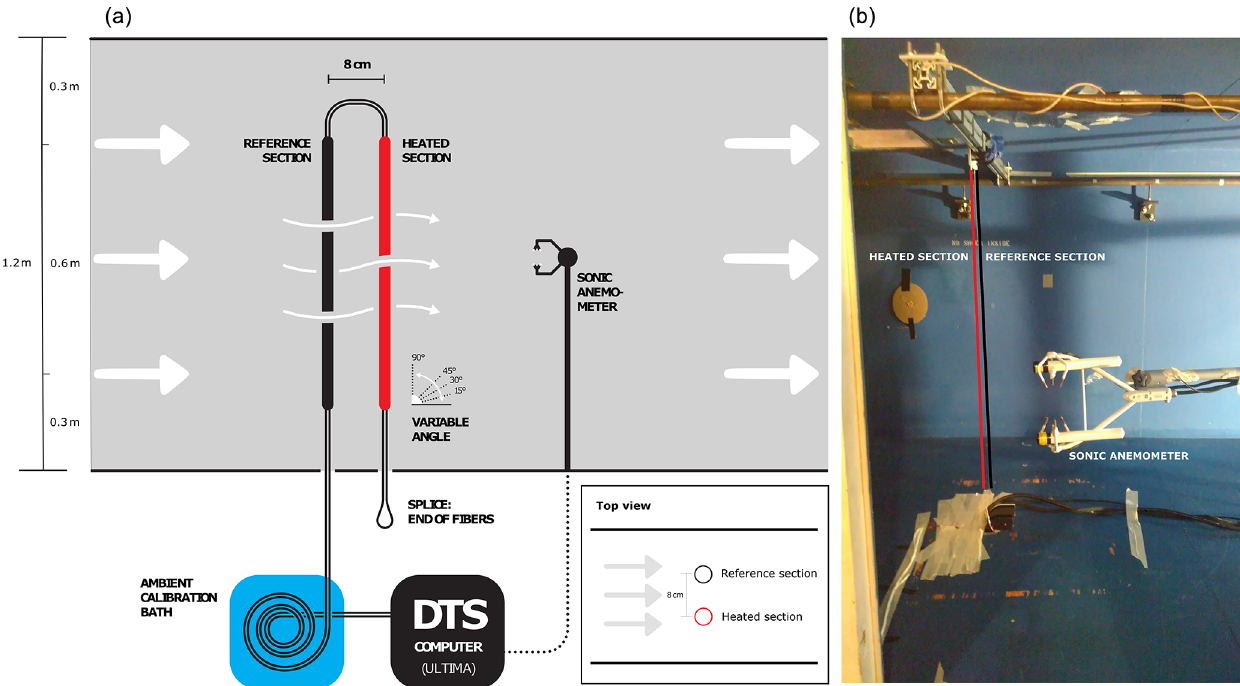
Figure 2. (a) Schematic of the wind tunnel setup and (b) photograph of the experimental setup in the wind